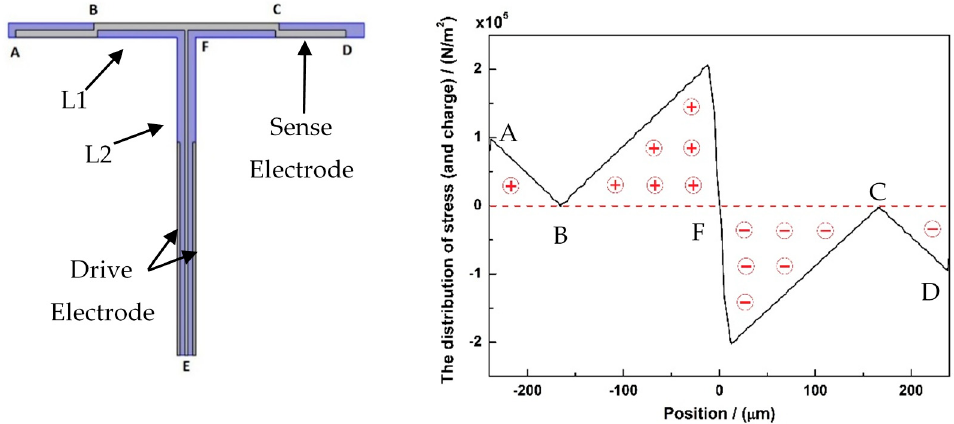
Figure 6. The stress distribution of drive mode along the sense electrode—ABCD. The positive/negative stresses will polarize positive/negative charges on the interface of AlN and electrodes.